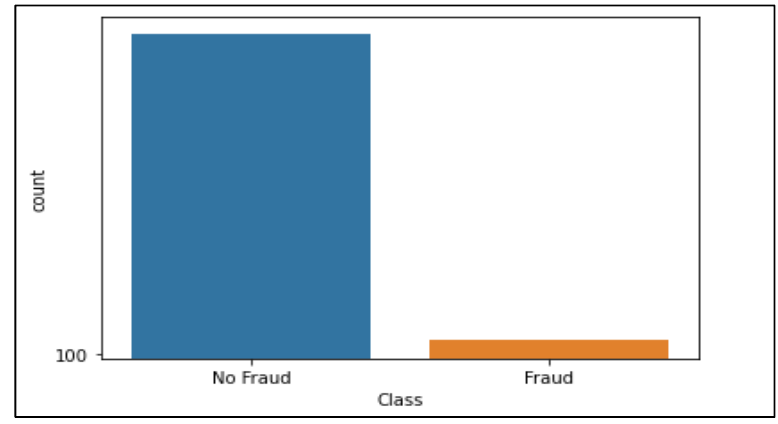
Figure 3. Imbalanced dataset.